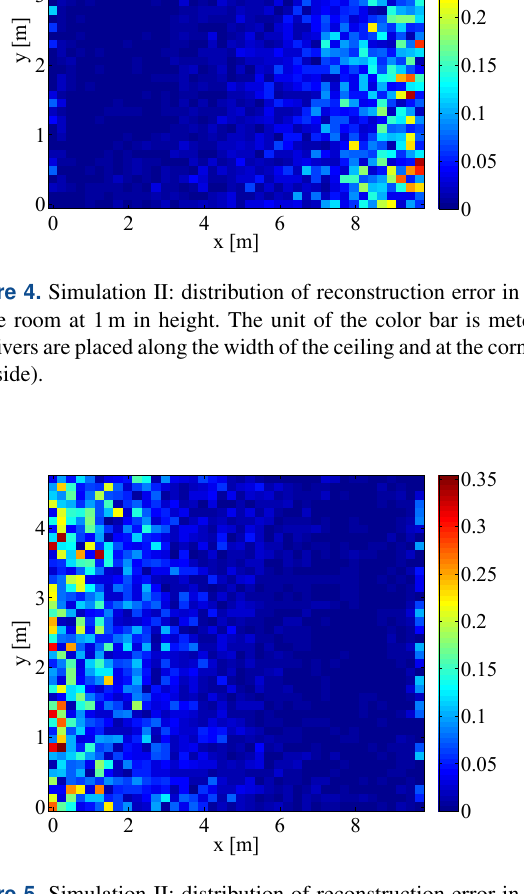
Figure 5. Simulation II: distribution of reconstruction error in the whole room at 1m in height using the second solution of Eq. (5). Two receivers are placed at the right ceiling’s corners and along the width in Fig. 3. The unit of the color bar is